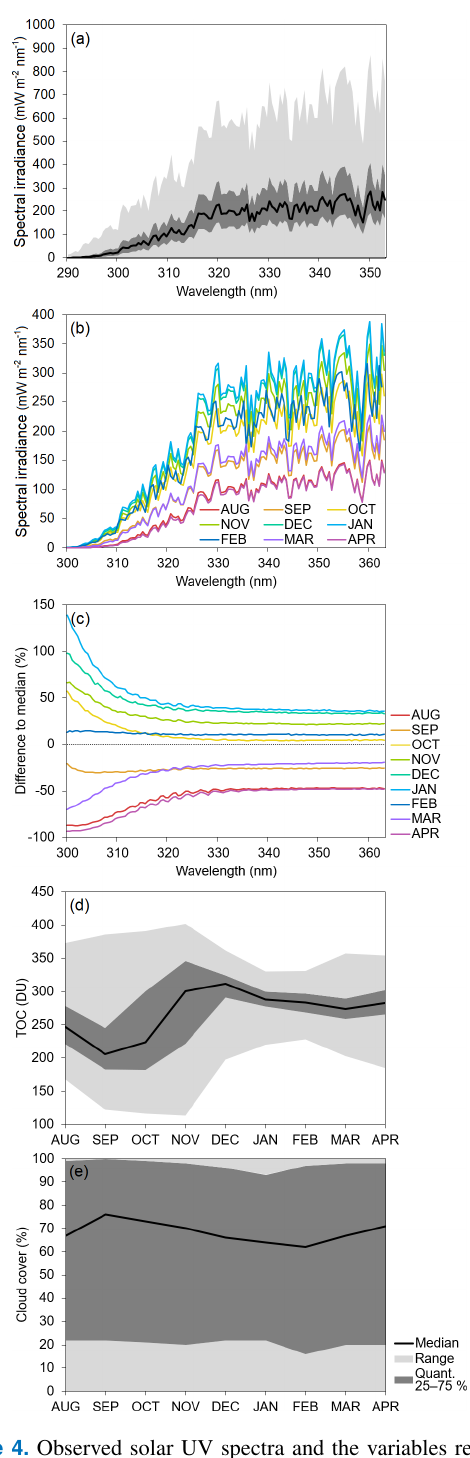
Figure 4. Observed solar UV spectra and the variables related to them obtained at Marambio Base in 2010–2020, where (a) repre- sents statistical characteristics of all spectra, (b) monthly medians, and (c) relative differences of monthly medians to overall median, and (d) and (e) show the climatology of TOC and cloud cover, re-